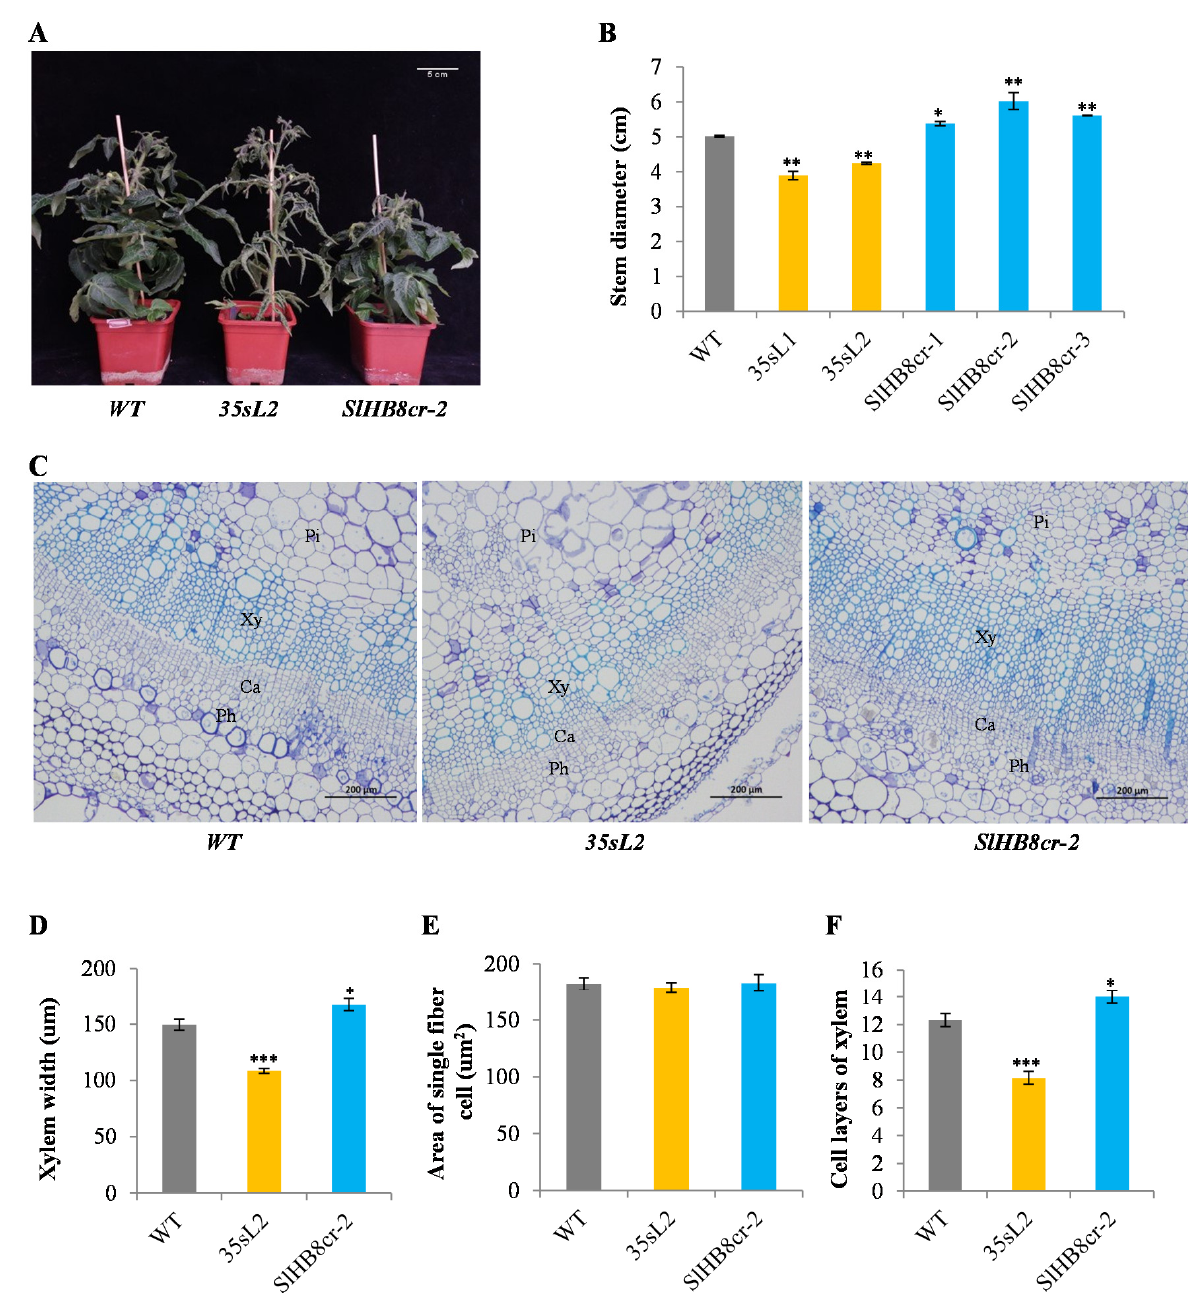
Figure 2. Phenotype analysis of SlHB8 overexpression and SlHB8 knock out lines. ( A ) Photos of adult plants of representative two-month-old SlHB8 overexpression and SlHB8 knock out lines. Bar: 5 cm; ( C ) Cross-sectioning and staining with toluidine blue of the 6th internode of 2-month-old wild-type, SlHB8 overexpression and SlHB8 knock out lines. Pi, pith; Ca, cambium; Ph, phloem; Xy, xylem. Bars: 200 um; ( B ) Measurement of stem diameter, ( D ) xylem width, ( E ) a single fiber cell size and ( F ) xylem cell layers in SlHB8 overexpression and SlHB8 knock out lines as well as WT plants. The calculation was performed on IMAGE J softer ware based on the images of toluidine blue-stained anatomical sections as described in the Materials and Methods section. In the bar chart, the gray barplots represent the wildtype line, the orange barplots represent the 35s-driven SlHB8 overexpression line, and the blue barplots represent the SlHB8 knockout line. Error bars mean ± standard error (SE) value. Stars indicate the statistical significance using Student’s t -test: * p -value < 0.05, ** p -value < 0.01, *** p -value <